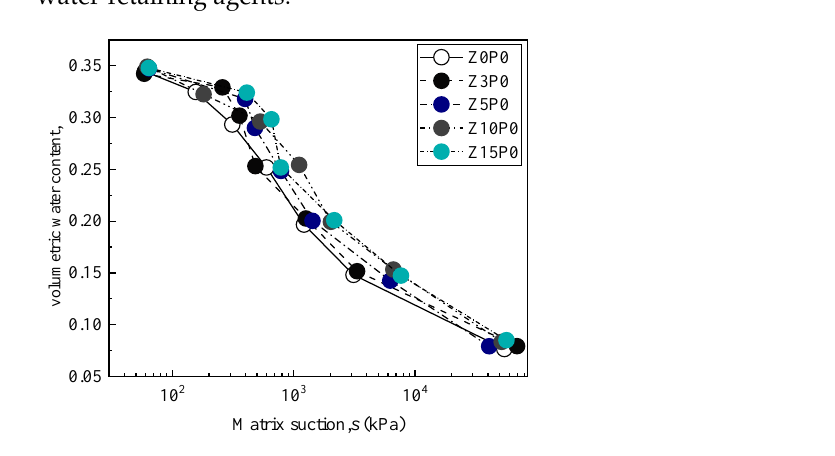
analyzed by examining the shape relationship of the SWCC of CCC modified by different water-retaining agents.